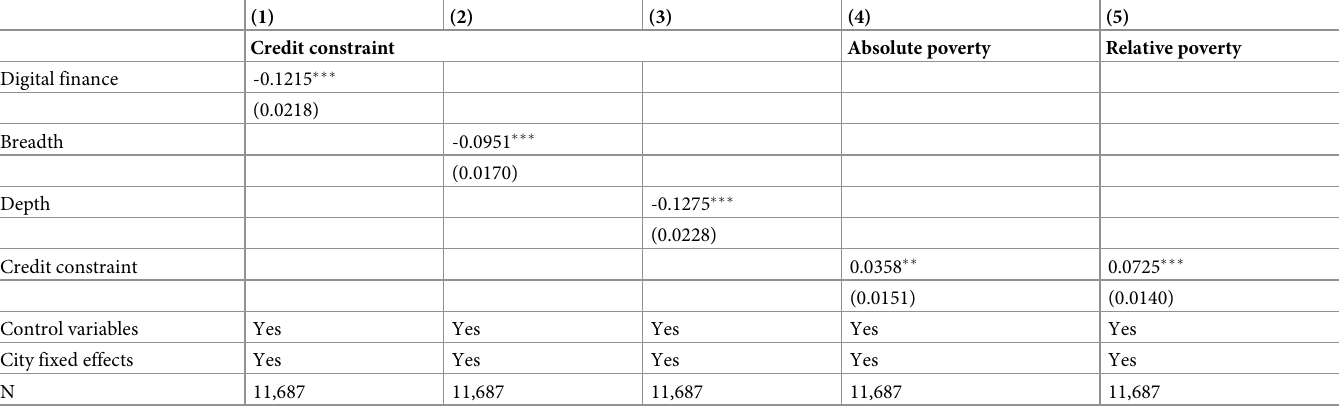
Table 4. Digital finance, credit constraints, and rural household